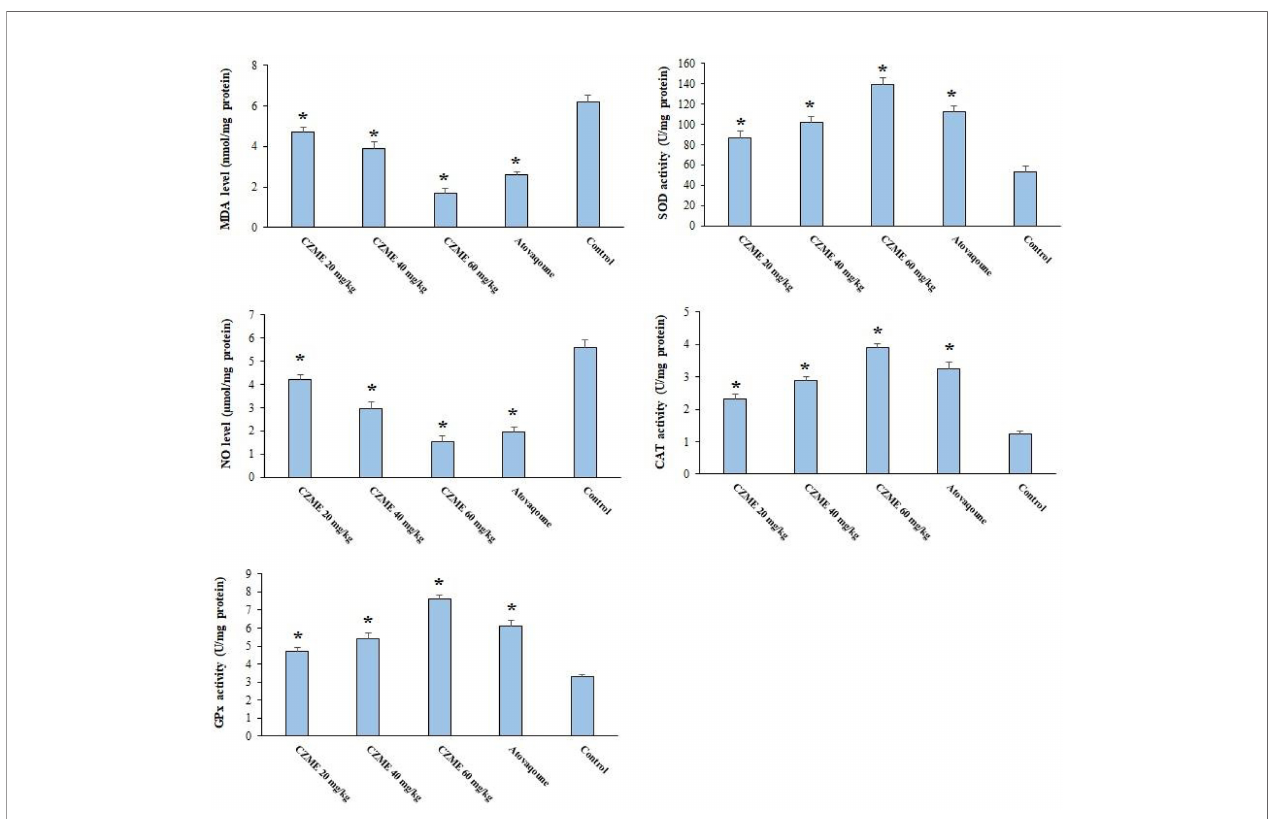
FIGURE 3 | Effect of C. zeylanicum methanolic extract (CZME) on the malondialdehyde (MDA), nitric oxide (NO), glutathione peroxidase (GPx), superoxide dismutase enzyme activity (SOD), and catalase enzyme (CAT) in infected mice in comparison with control groups. Mean ± SD (n = 8). *p <